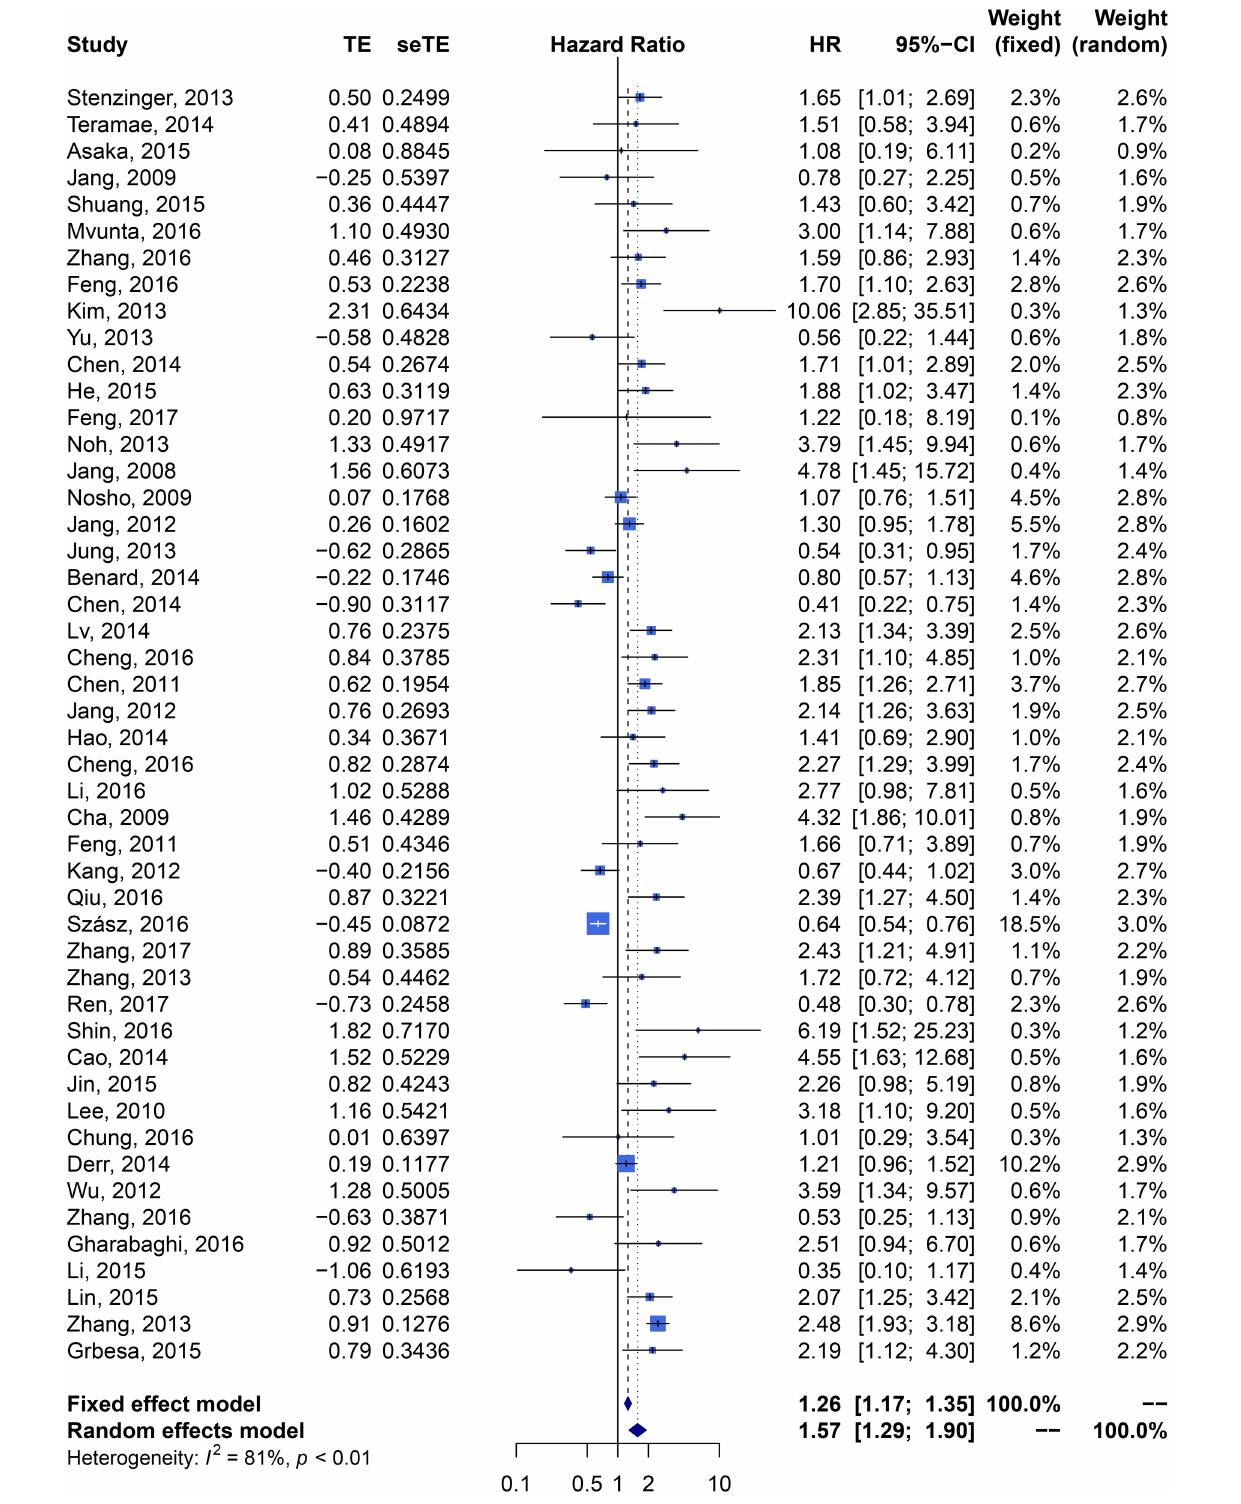
Frontiers in Endocrinology |